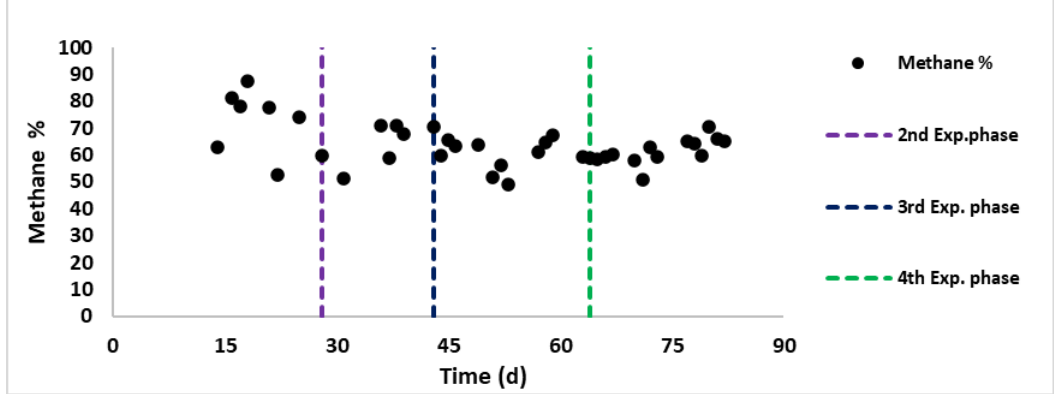
Figure 12 . Daily methane concentration of biogas generated from the PABR.